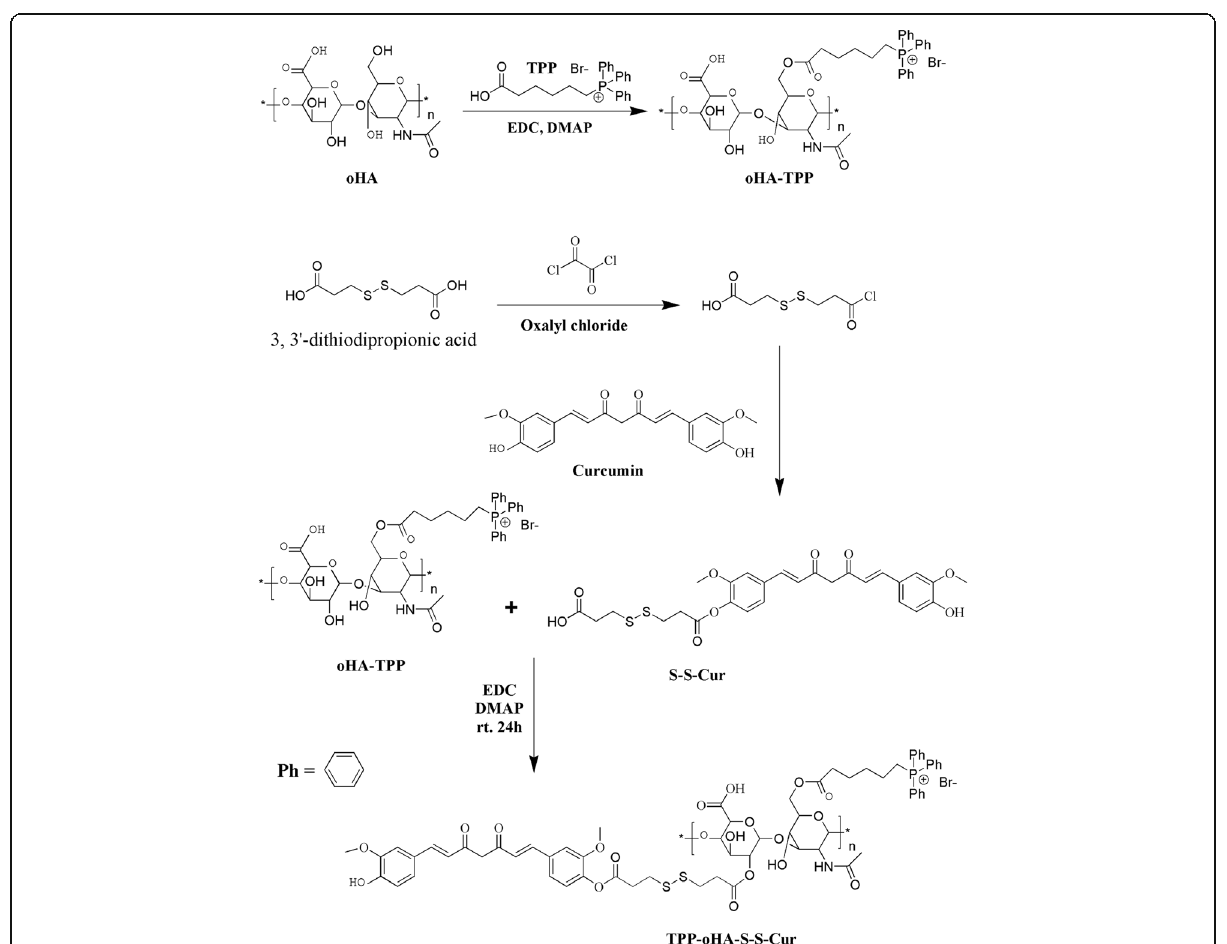
Fig. 2 Synthetic route of TPP-oHA, S-S-Cur, and